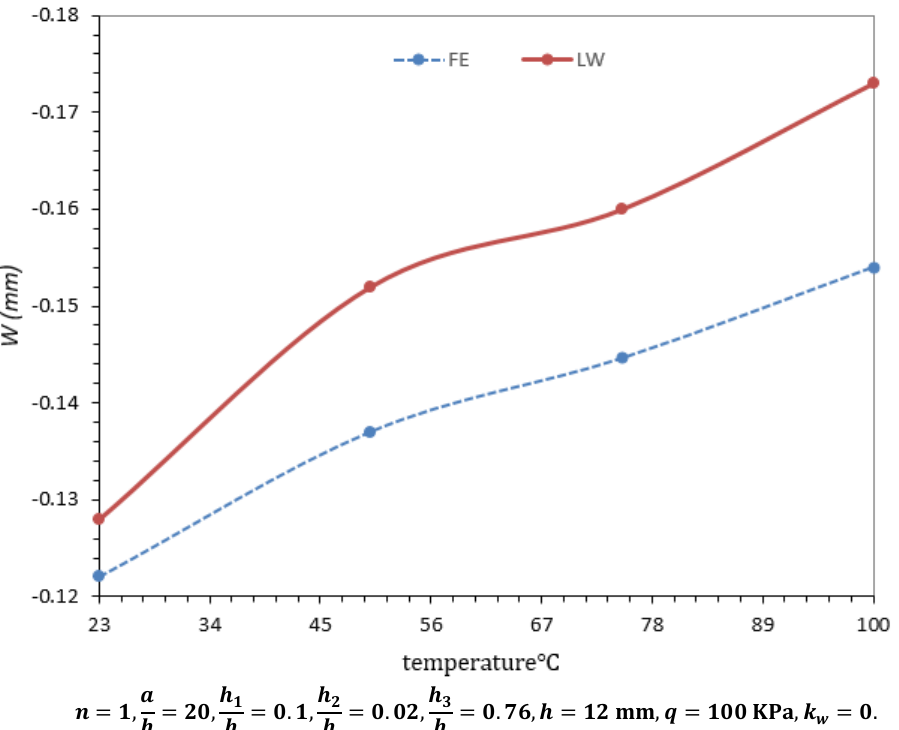
Figure 4. Effect of the thermal loads on the center deflection of the sandwich (for point 1) plate.